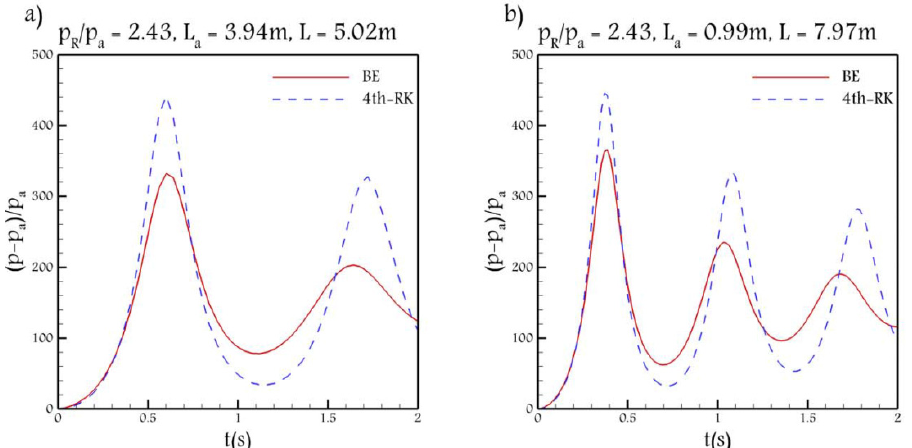
Figure 6. The non-dimensional air absolute pressure (p p (cid:2911) ⁄ ) distribution vs. the time, calculated by both backward Euler scheme, and classical 4th order Runge–Kutta scheme, for a test case of Zhou [20], p (cid:2902) p (cid:2911) ⁄ = 2.43 and ( a ) λ = 0.56 , and ( b ) λ = 0.89 , both with the same value of f L (cid:2911) D⁄ .